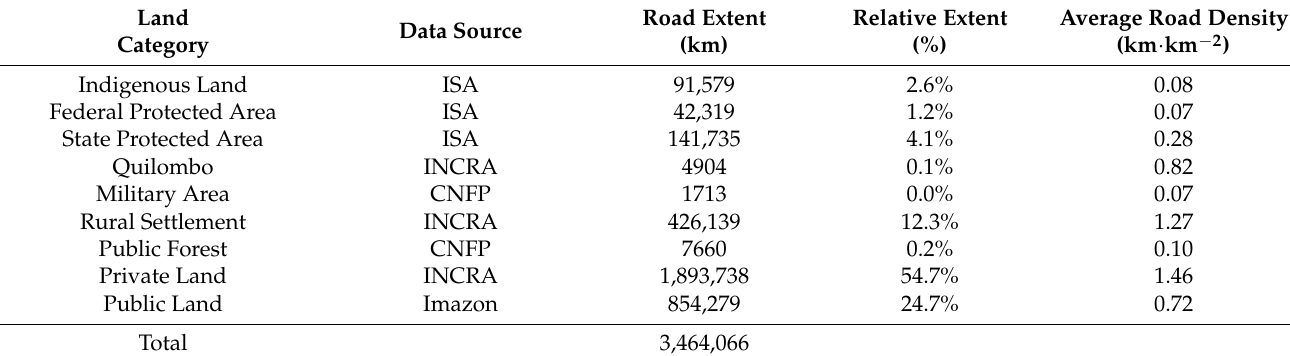
Table 2. Road extent and density by land